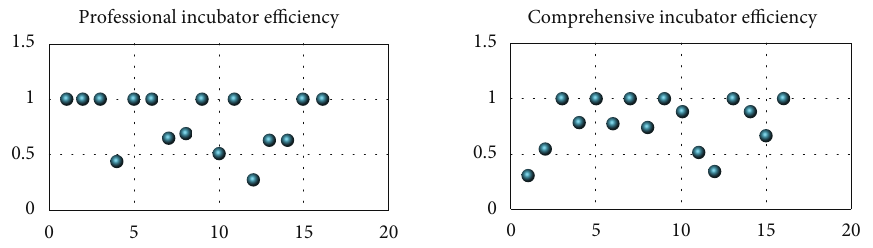
Figure 6: Results of e ffi ciency analysis of di ff erent types of